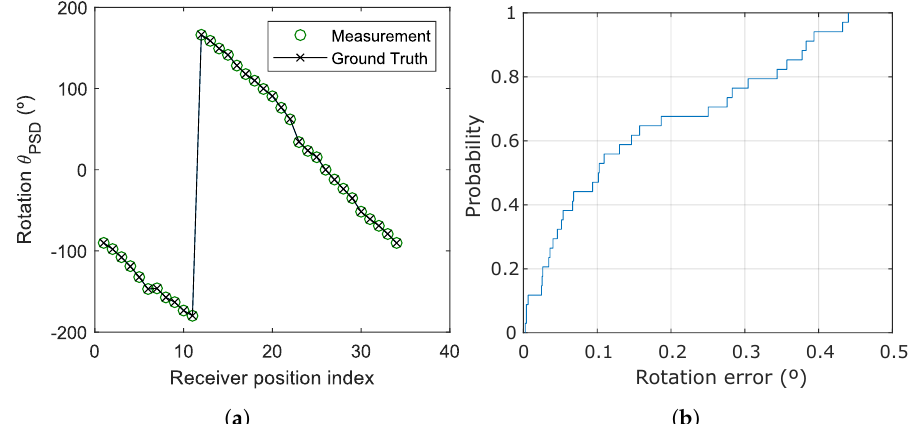
Figure 10. Rotation angle results using Emitters 1 and 4. ( a ) Calculation of the rotation angle; ( b ) CDF of the rotation error.